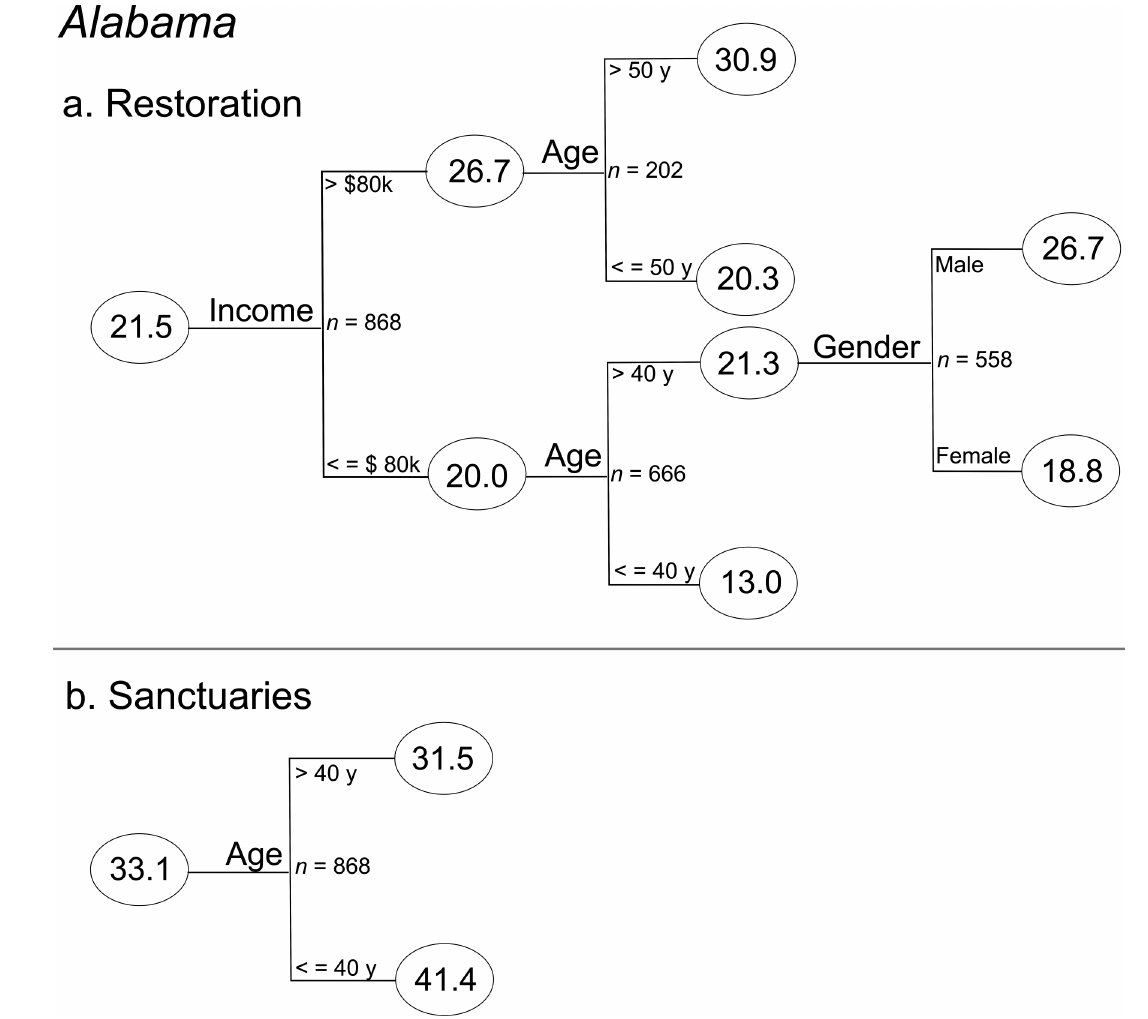
Fig. 5 . Tree showing the most powerful predictors for explaining variability among individuals who perceived restoration (a) and spawning sanctuaries (b) as the most effective stewardship initiative in Alabama. The value shown within each oval is percent response for most effective, and separate branches within the tree indicate statistical differences at P ≤